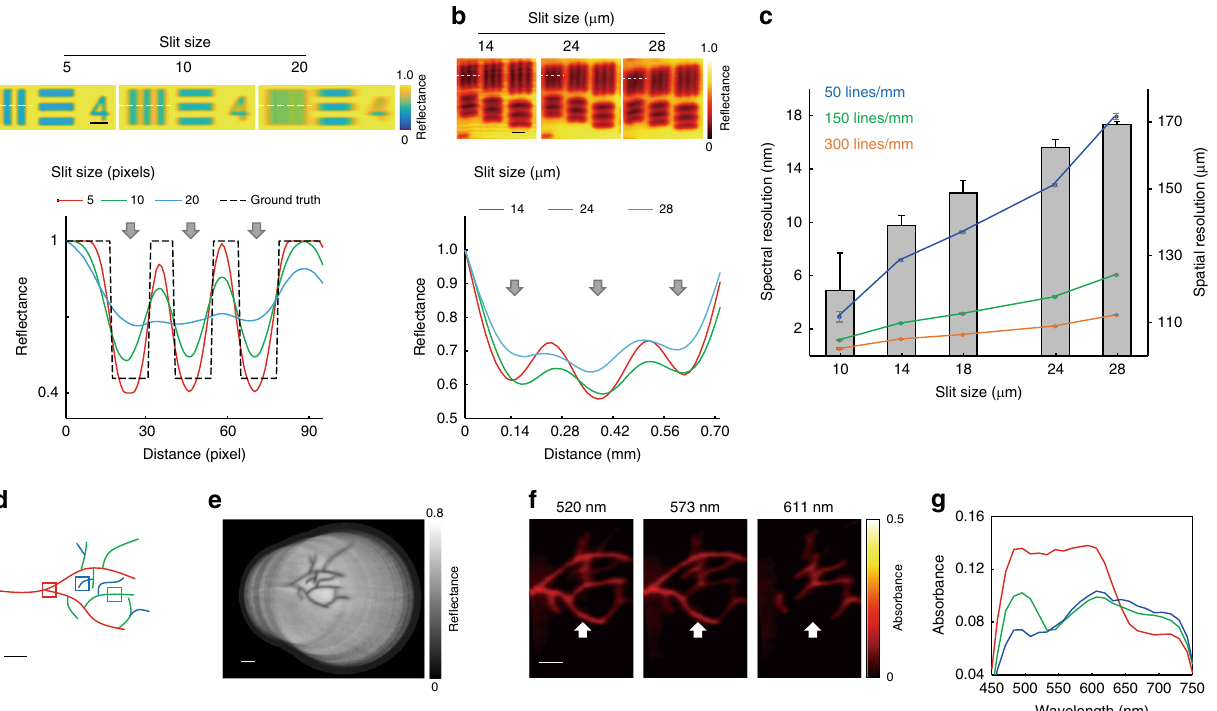
Fig. 4 Characterisation of spatiospectral resolution of HySE. Spatiospectral resolution and signal intensity can be optimised by adjusting the spectrograph slit size, which enables hyperspectral imaging (HSI) during freehand motion. a Maximum intensity projection of simulated spectral images of a USAF 1951 test target at three different slit sizes (5, 10 and 20 pixels). Grey arrows indicate the three vertical lines across which the intensity pro fi le (white dashed line) is quanti fi ed in the graph. The three chart elements are clearly resolved for slit sizes of 5 or 10 but at a slit size of 20 pixels, contrast is lost. b Experimentally measured images of a USAF 1951 test target at three different slit sizes (14, 24 and 28 μ m). As in simulation, the three chart elements lose contrast as the slit size increases. Images show a representative slice of the hypercube at 518 nm. c The graph shows the trade-off between spatial resolution (bar graph; right axis) and spectral resolution (line graph; left axis) at the same exposure time for different slit sizes. Images acquired using external illumination. Error bars represent standard deviation in bars and lines. d A vascular tree phantom was created using three colours to demonstrate freehand HSI (see also Supplementary Movie 2). The internal illumination method was used during freehand imaging. e During freehand imaging, wide- fi eld registration was performed. A combination of 86 endoscopic wide- fi eld images is shown. f Representative slice images from the reconstructed hypercube are illustrated at three wavelengths. White arrows indicate the presence and absence of red vascular structures in the different single wavelength images. Colour bar indicates absorbance. g Absorbance was quanti fi ed within the red, green and blue squares shown in d . Images acquired using internal illumination. Scale bar in simulation a = 25 pixels, scale bar in experiment b = 500 μ m and scale bars in d – f = 10 (Fig. 4e) and reconstructed hypercube (single wavelength slices shown in Fig. 4f). As expected, the absorbance image at 611 nm clearly shows the disappearance of red coloured vascular patterns.